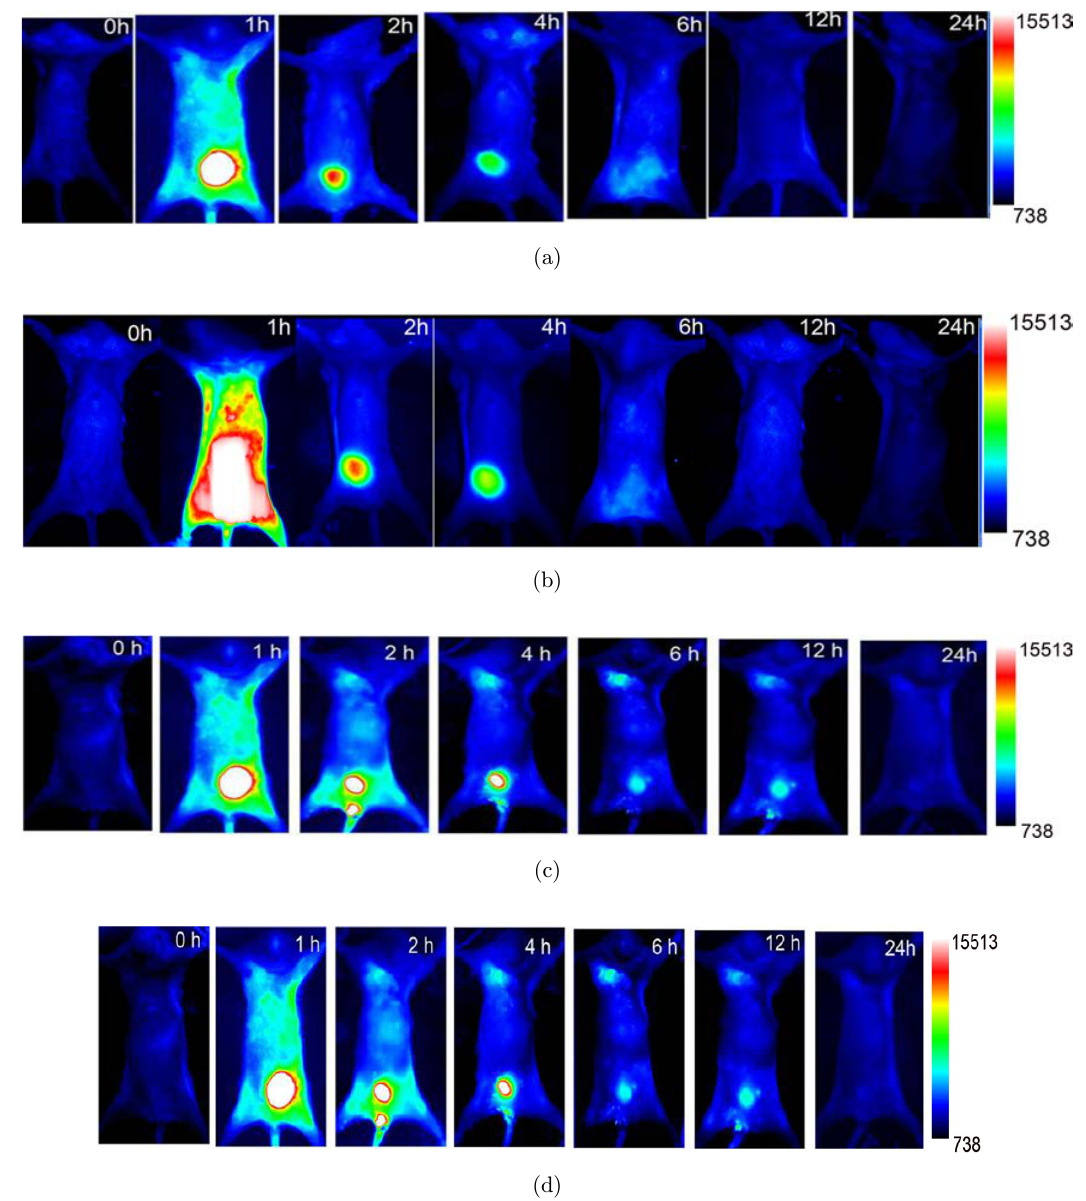
Fig. 4. NIR images of Balb/C mice. The distribution of the probe UBI29-41-ICG02 (a) and the dye ICG-Der-02 (b) in healthy mice and the distribution of the probe UBI29-41-ICG02 (c) and the dye ICG-Der-02 (d) in infected mice, and the infection site is on the right axillary